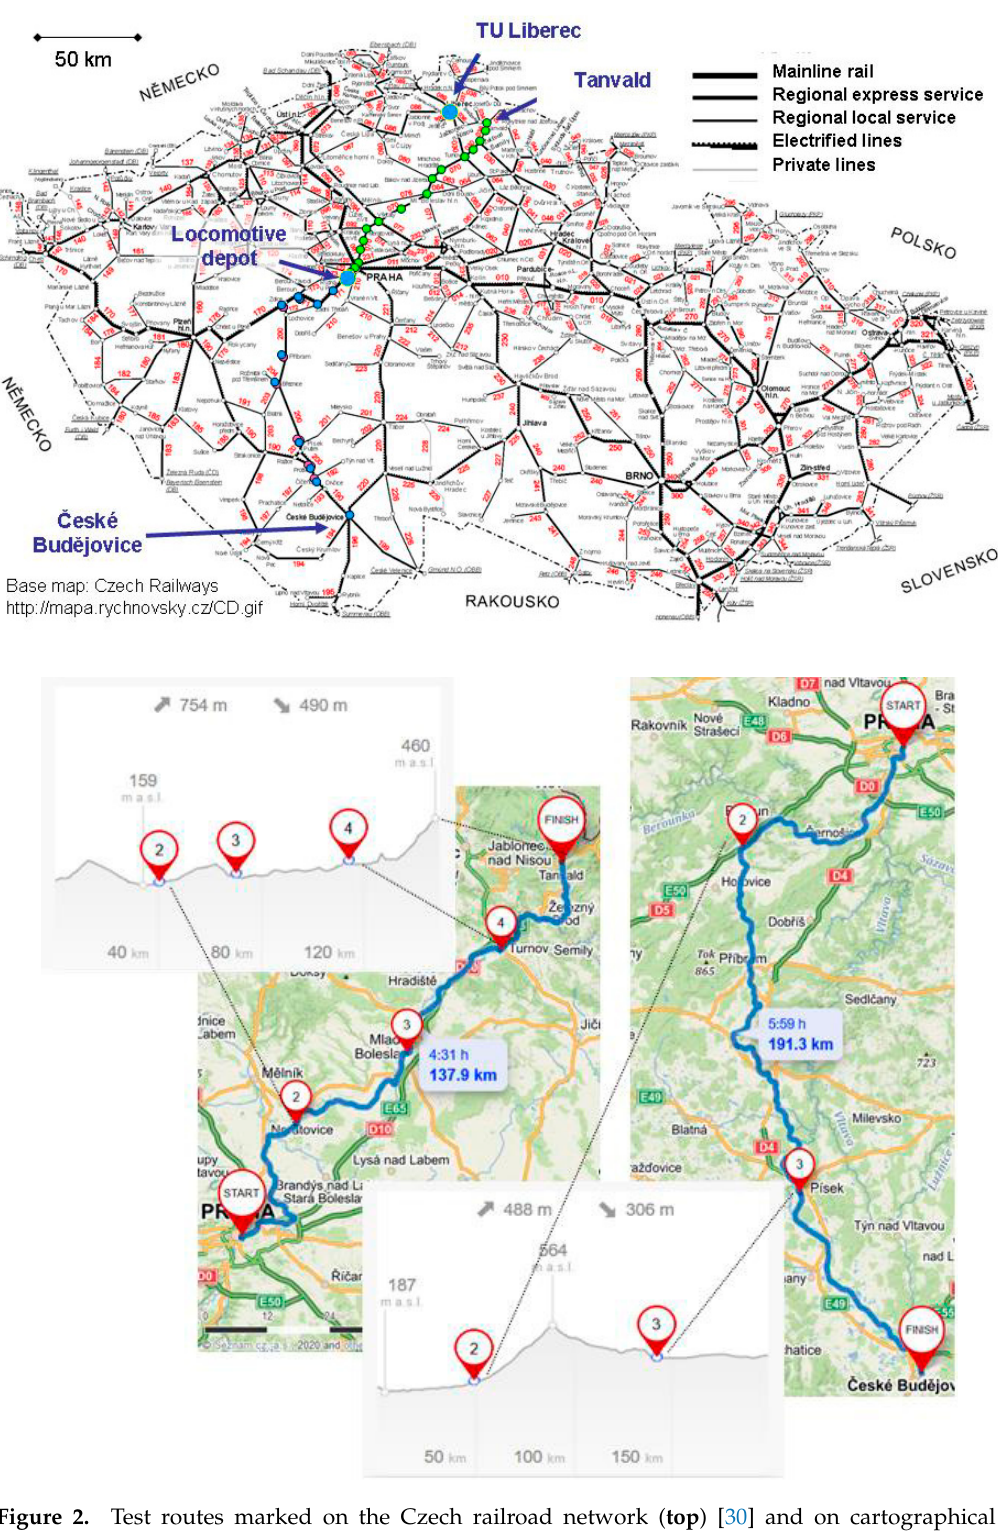
Figure 2. Test routes marked on the Czech railroad network ( top ) [30] and on cartographical maps ( bottom ) with associated elevation profiles (source: [31]) with highlighted operated routes and marked major points: Praha–Tanvald ( left ): 2, Vsetaty; 3, Mlada Boleslav; and 4, Turnov; Praha–Ceske Budejovice ( right ): 2, Zdice; 3, Pisek.